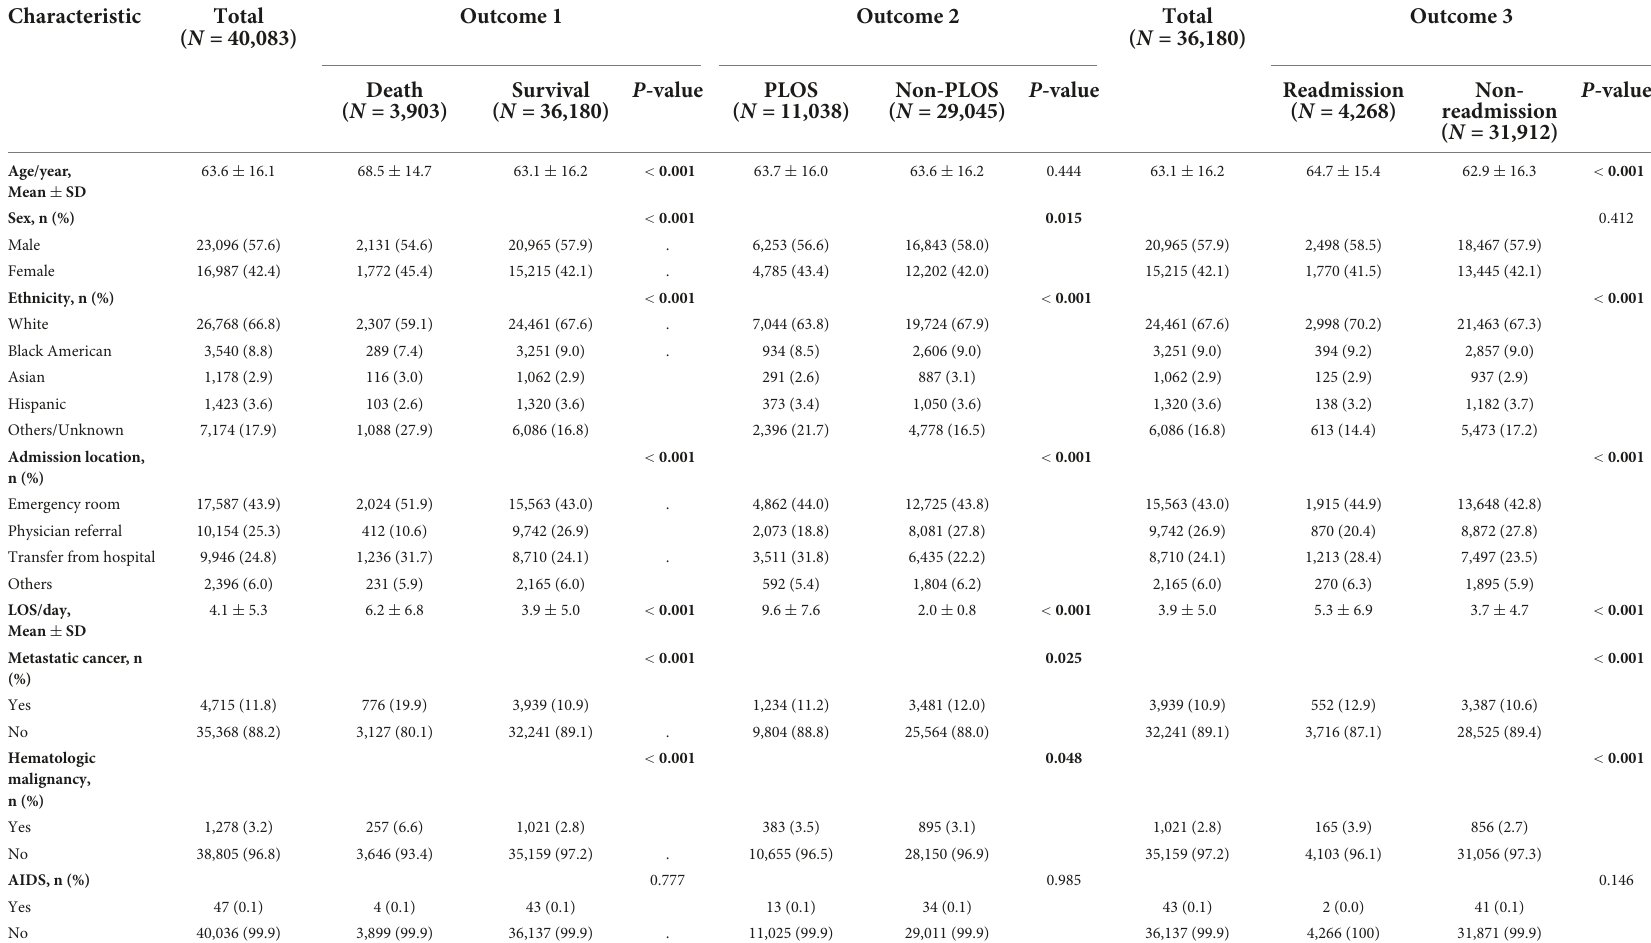
TABLE 1 Characteristics of study participants grouped by